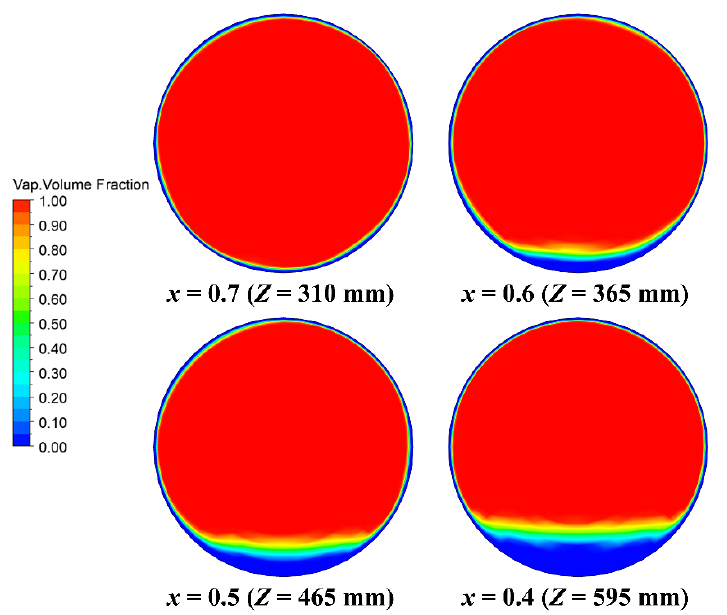
Figure 5. Cross-section distribution of vapor phase volume fraction at different vapor quality under mass flux G = 400 kg/(m 2 ·s).